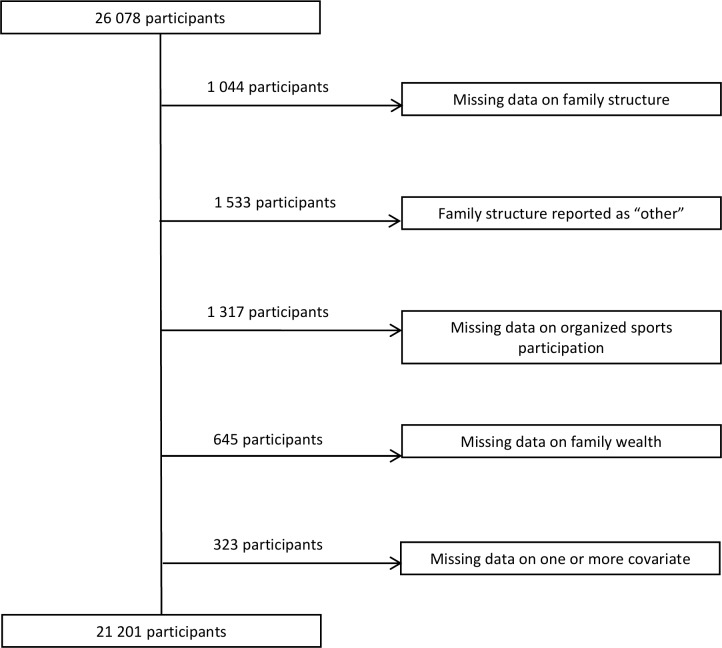
Flow chart of inclusion information for participants.